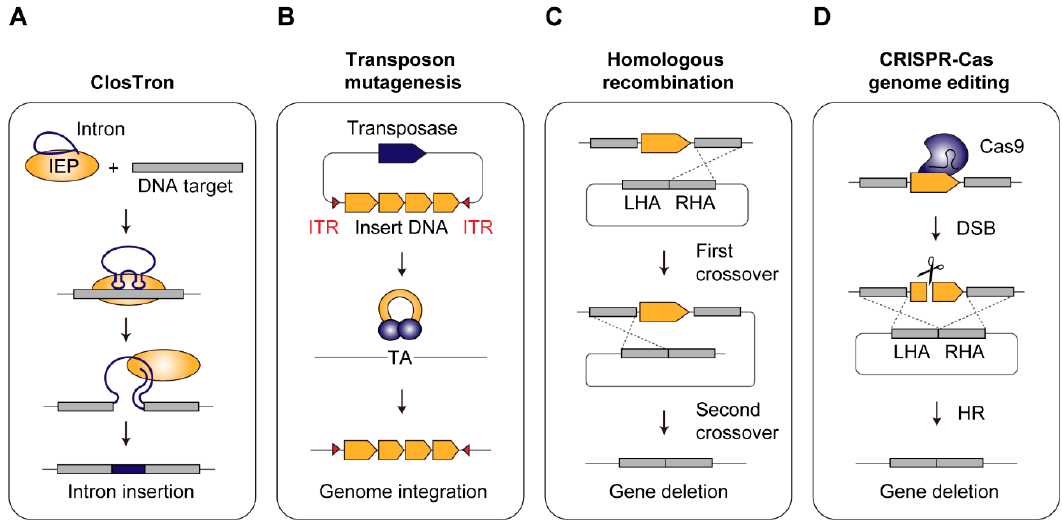
Figure 1. Genome engineering tools used in acetogens. ( A ). ClosTron is based on a complex form of an intron and intron-encoded protein and it inserts the intron into the target site in the genome. ( B ). Transposon mutagenesis inserts DNA sequences flanked by inverted terminal repeats (ITRs) into the genome by randomly recognizing a “TA” site in the genome. ( C ). Double-crossover homologous recombination occurs in two steps. The first crossover incorporates the entire vector into the genome and the subsequent second crossover removes the region between the left homology arm (LHA) and the right homology arm (RHA). ( D ). CRISPR-Cas system utilizes Cas9 and gRNA, which induces a double-stranded break (DSB) in the genome. The DSB can be repaired by homologous recombination between donor DNA and the host chromosome.